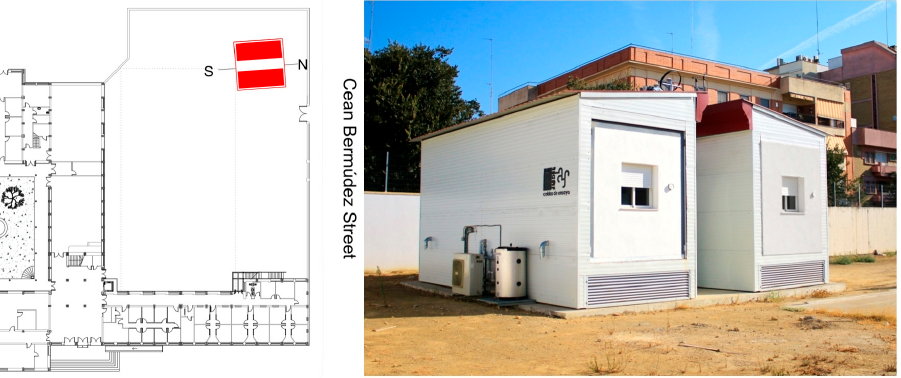
Figure 1. Location site with N-S (North-South) orientations; external appearance of the test modules.